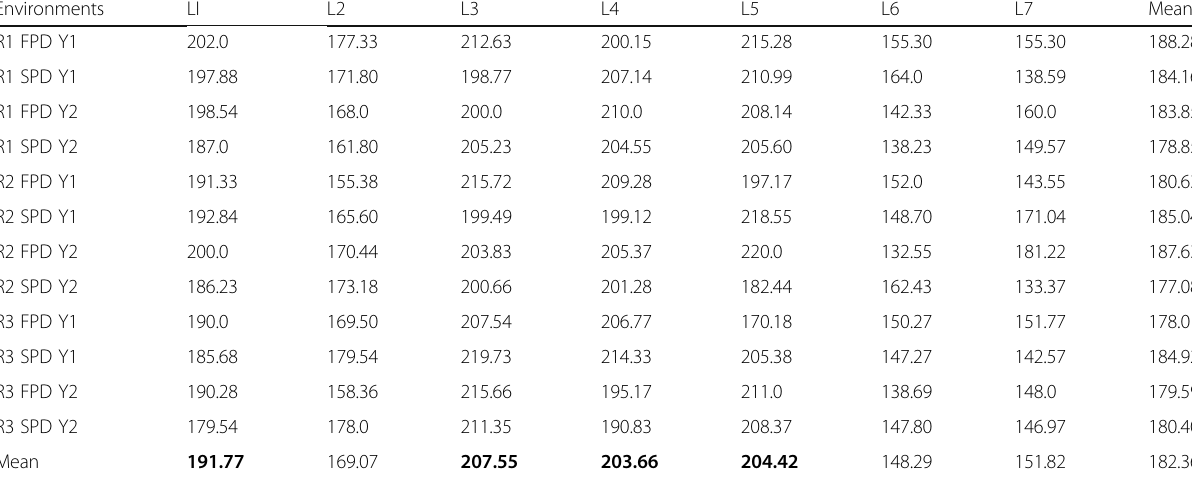
Table 8 The mean values for the seven rice entries under all conditions for number of filled grains/panicle Environments